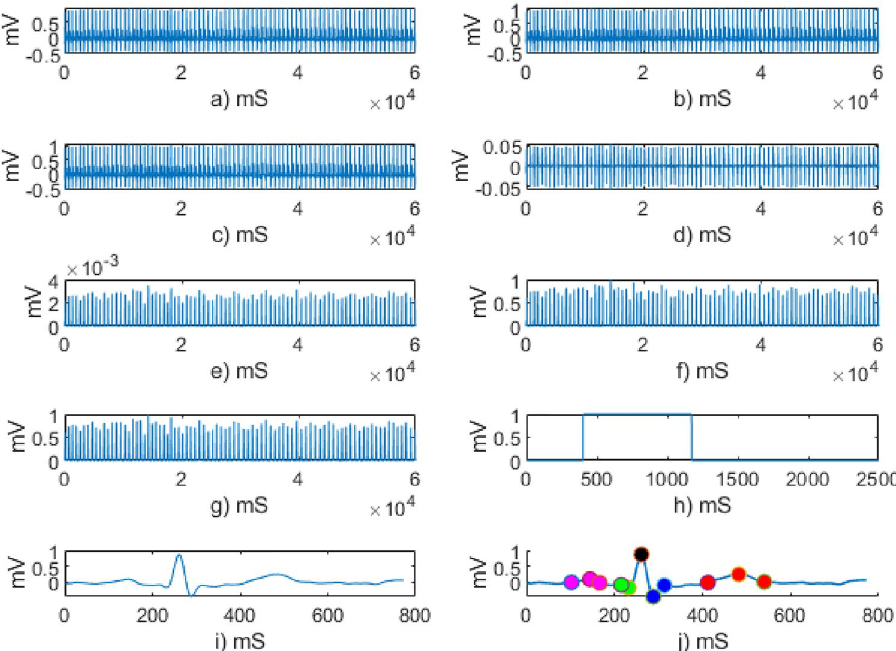
Figure 6. QRS detection using pan Tompkins: ( a ) Input signal, ( b ) low pass filtered ( c ) high pass filtered, ( d ) derivative filtered ( e ) signal squaring, ( f ) signal after normalization, ( g ) moving average filtered, ( h ) moving window and the portion of signal in the ( i ) moving window and ( j ) detected fiducial